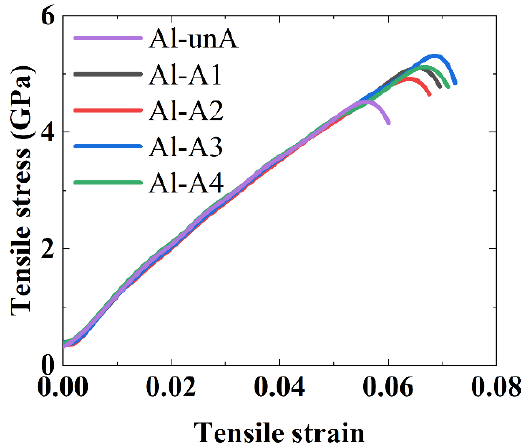
Figure 11. The tensile stress–strain curves of the Al 2 Cu–Al structures before annealing and at differ ‐ ent temperatures of annealing. temperatures of